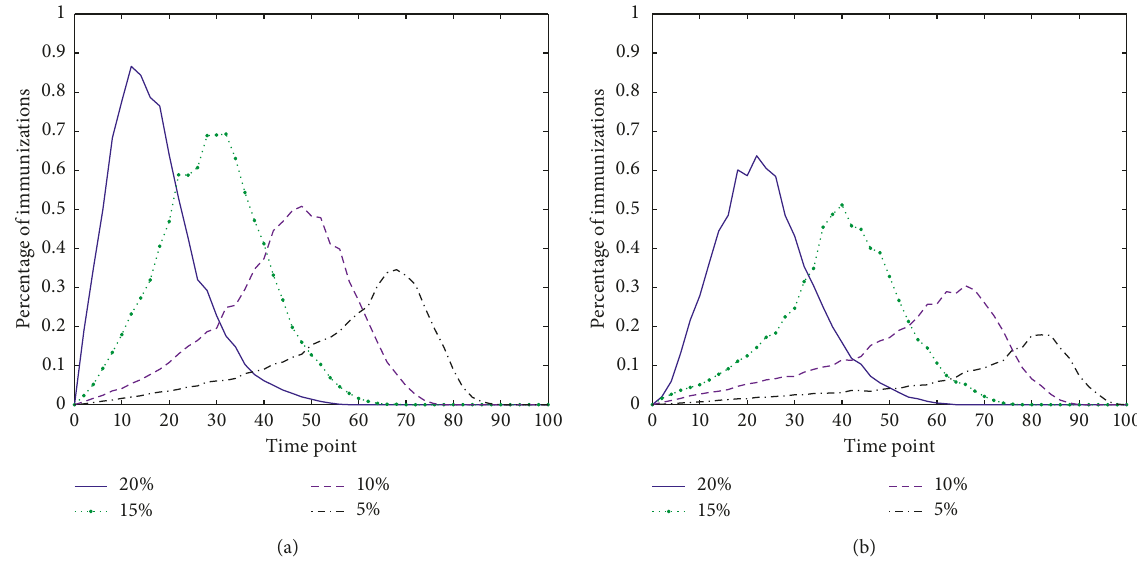
Figure 15: Percentage of immunizations with initially infected ratio μ � 5% , 10% , 15%, and 20%: Haggle (a) and MT Reality